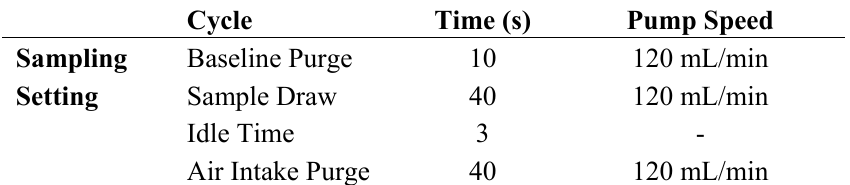
Table 3. E-nose Parameter